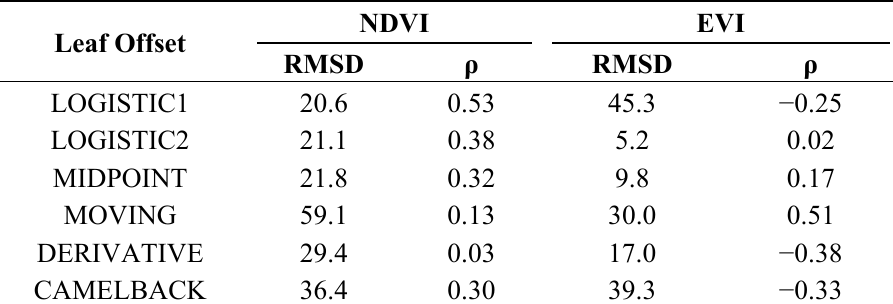
Table 4. Performance of remotely sensed